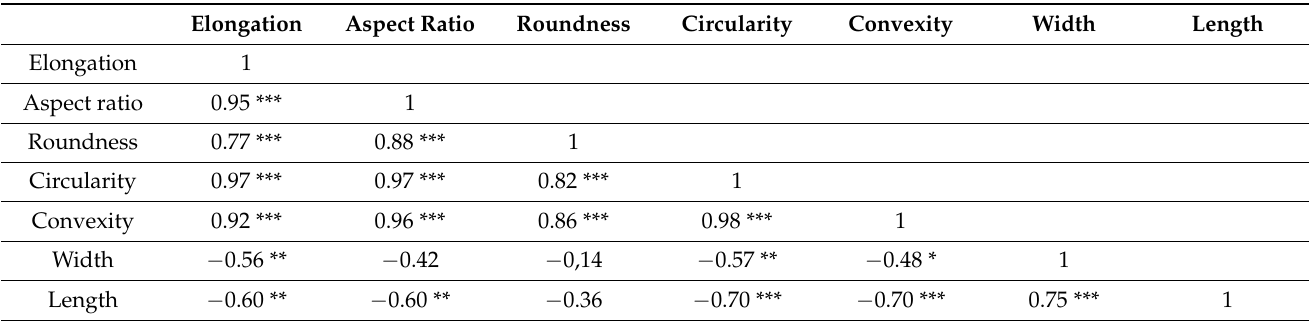
Table 4. Correlation matrix between arithmetic means of particle shape and size descriptors for the 22 growing media constituents studied.